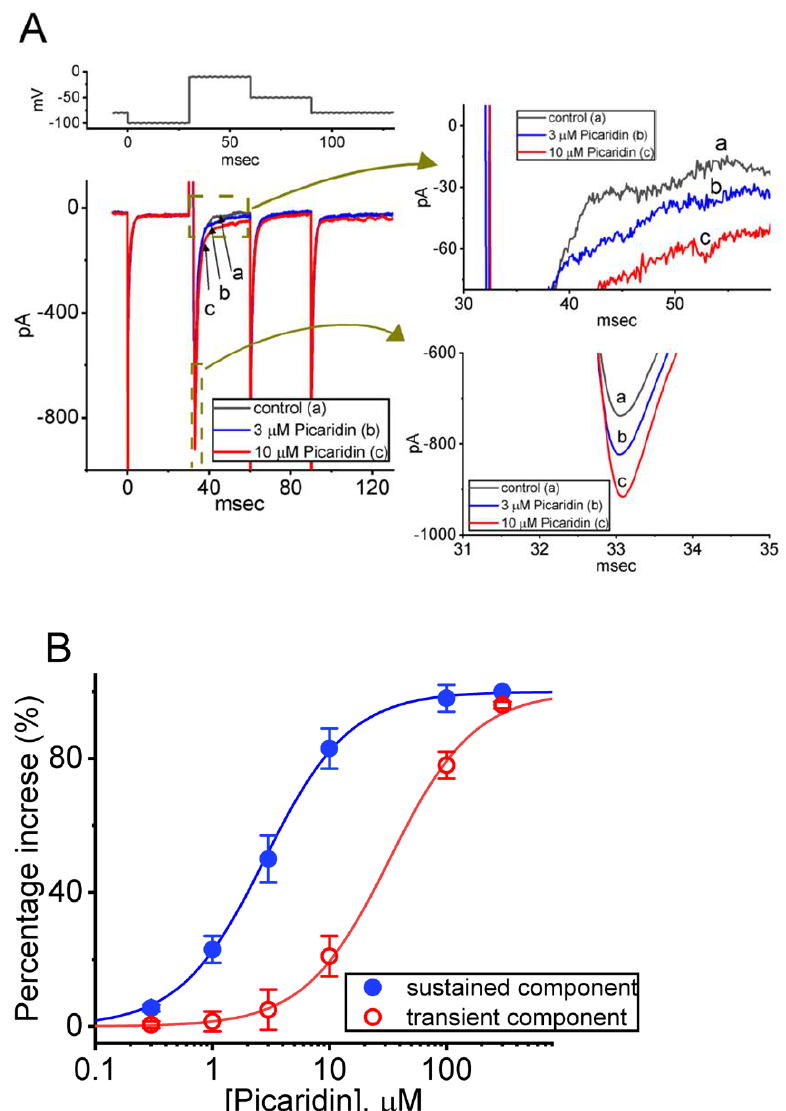
Figure 1. Stimulatory effect of picaridin on voltage-gated Na + current ( I Na ) measured from pituitary GH 3 cells. In this set of measurements, we placed cells in Ca 2+ -free Tyrode’s solution containing 0.5 mM CdCl 2 and 10 mM tetraethylammonium chloride (TEA), and the recording pipette was filled up with a Cs + -enriched solution. ( A ) Exemplar current traces evoked by a 30-ms depolarizing pulse from −100 to − 10 mV (indicated in the uppermost part ( A )). a: control (i.e., picaridin was not present); b: 3 μM picaridin; and c: 10 μM picaridin. The right side shows the expanded records with curve arrows from the brown dashed boxes in the left side. ( B ) Concentration-dependent stimulation of transient (peak, I Na(T) , red open circles) or sustained (late, I Na(L) , blue filled circles) caused by picaridin. The amplitude of I Na(T) or I Na(L) was taken at the start- or end-pulse of the depolariz- ing command voltage from − 100 to − 10 mV for a duration of 30 ms. Each point represents the mean ± SEM (n = 8). The sigmoidal curves, on which the data points are overlaid, were reliably fitted to a modified Hill equation, as detailed under Materials and